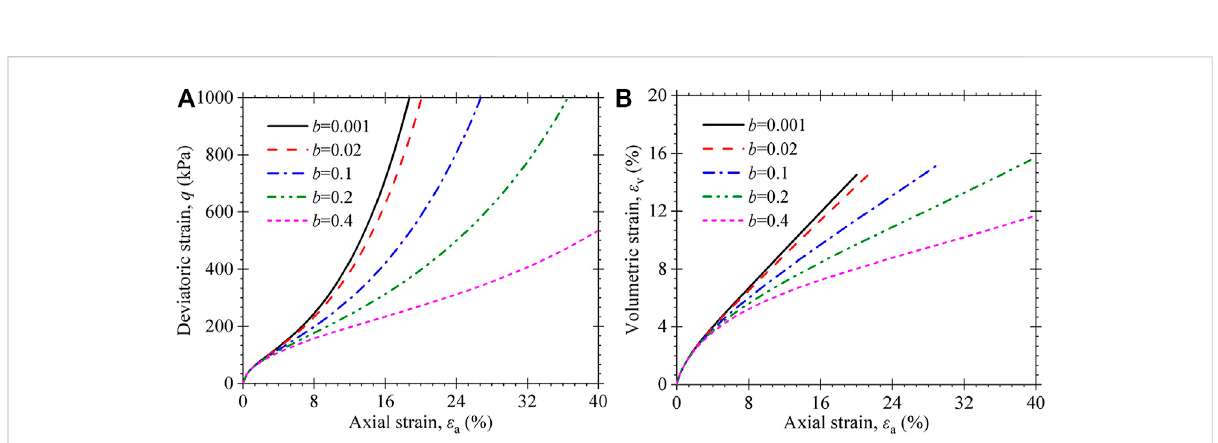
In fl uence of parameter b on the stress – strain behavior of MSW: (A) stress – strain curves; (B) volumetric strain vs. axial strain curves.